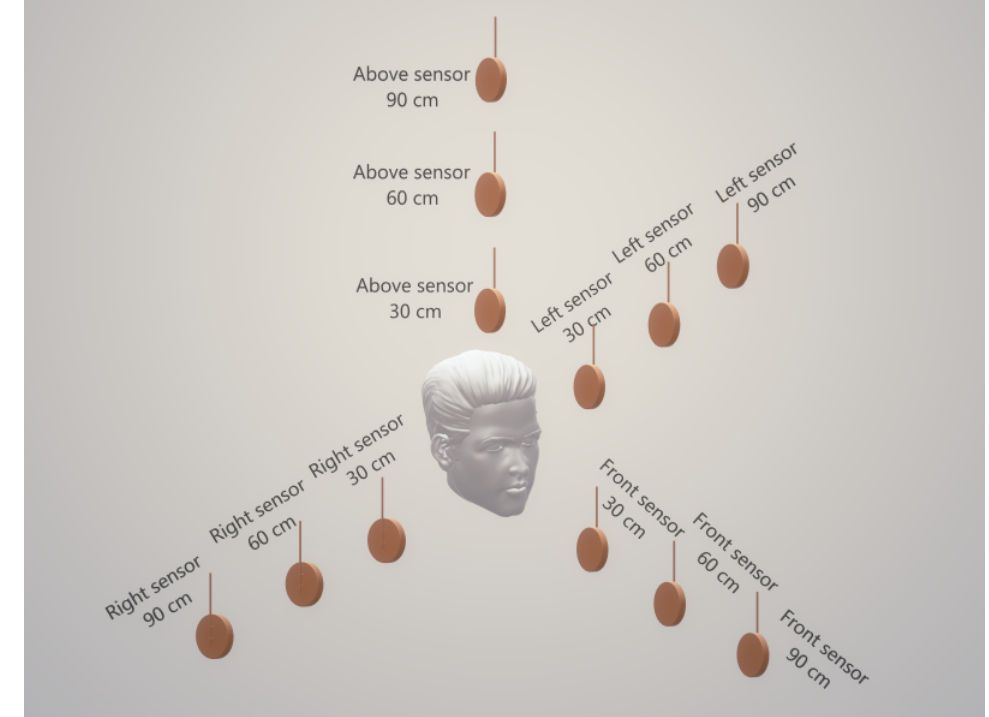
Figure 2. Experimental